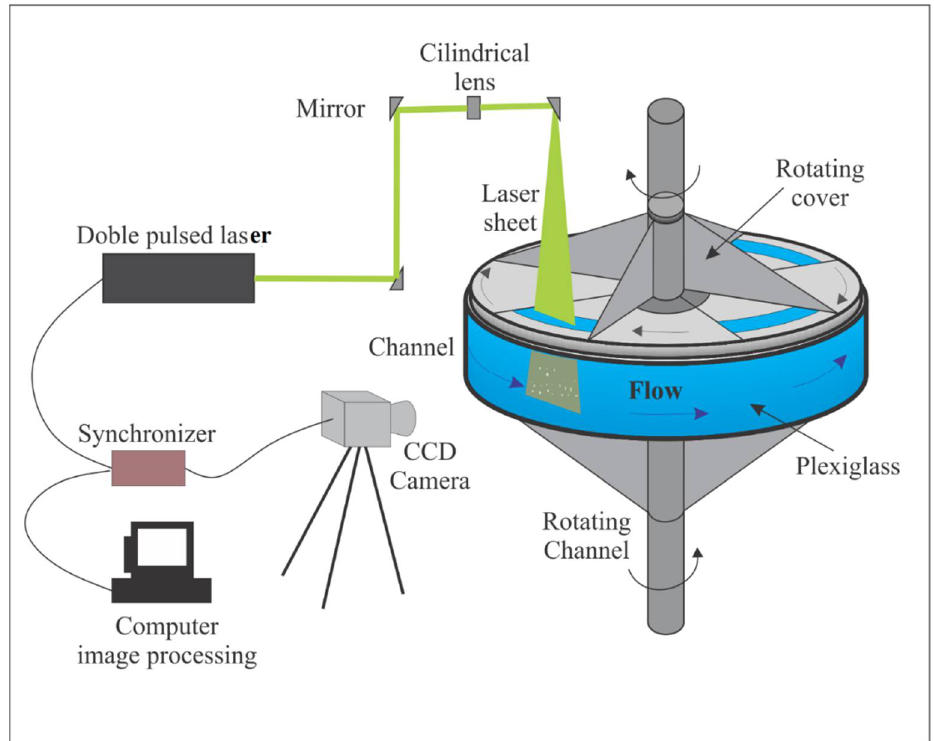
Figure 2. Experimental setup for tests in Rotating Annular Flume (RAF).